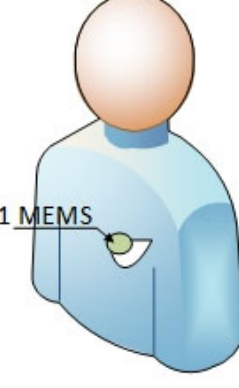
Figure 6. Position of accelerometer.